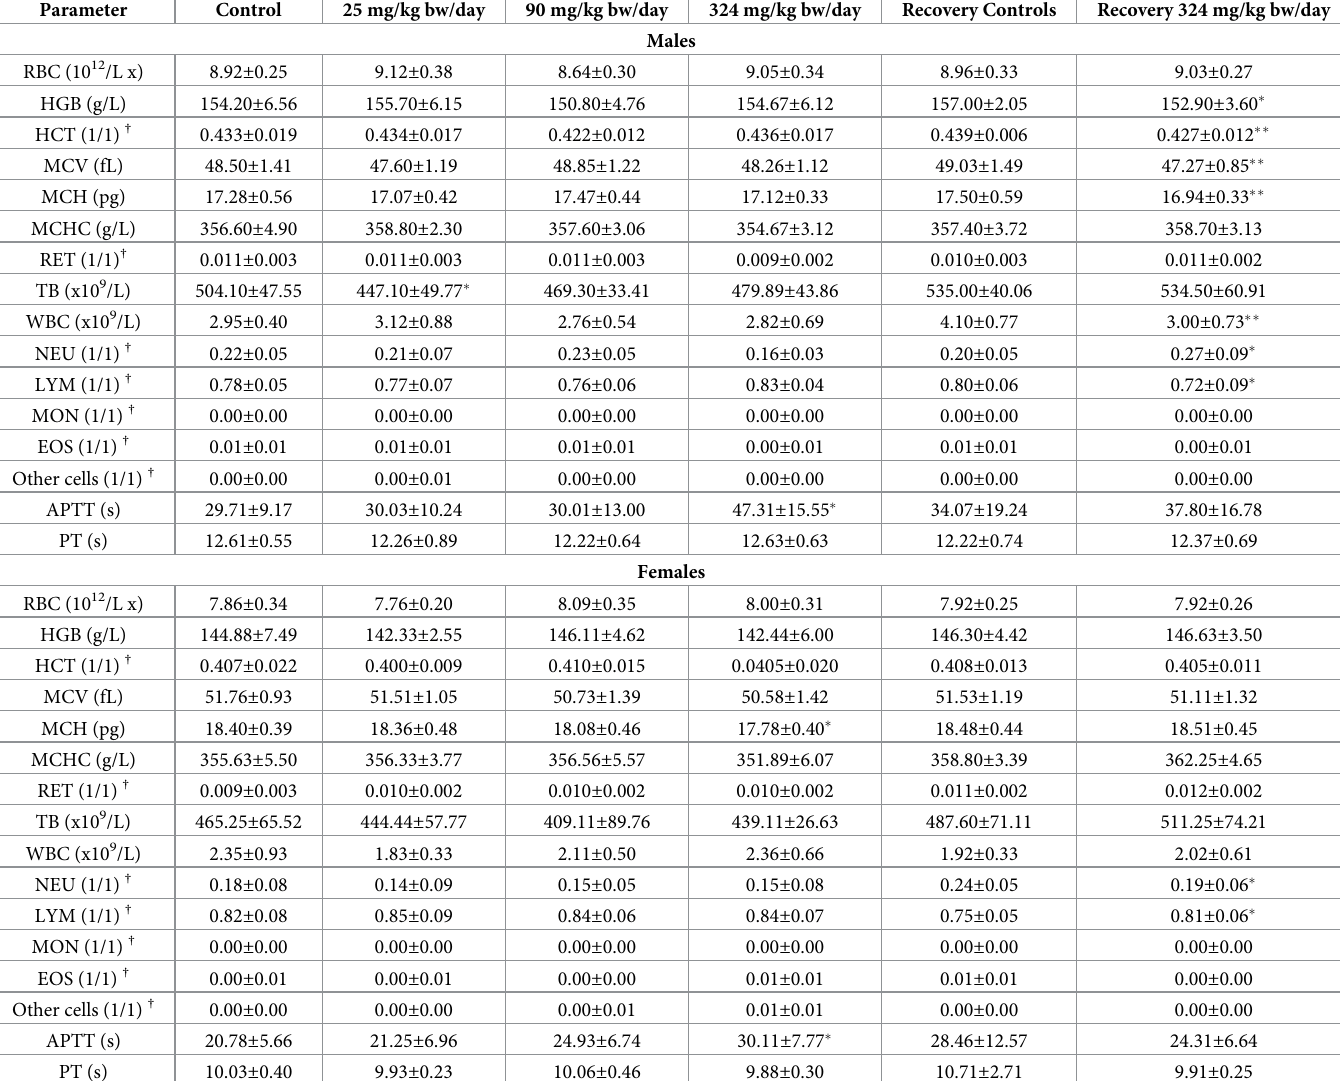
Table 3. Hematology and coagulation data for the 90-day study—Main study and recovery animals.